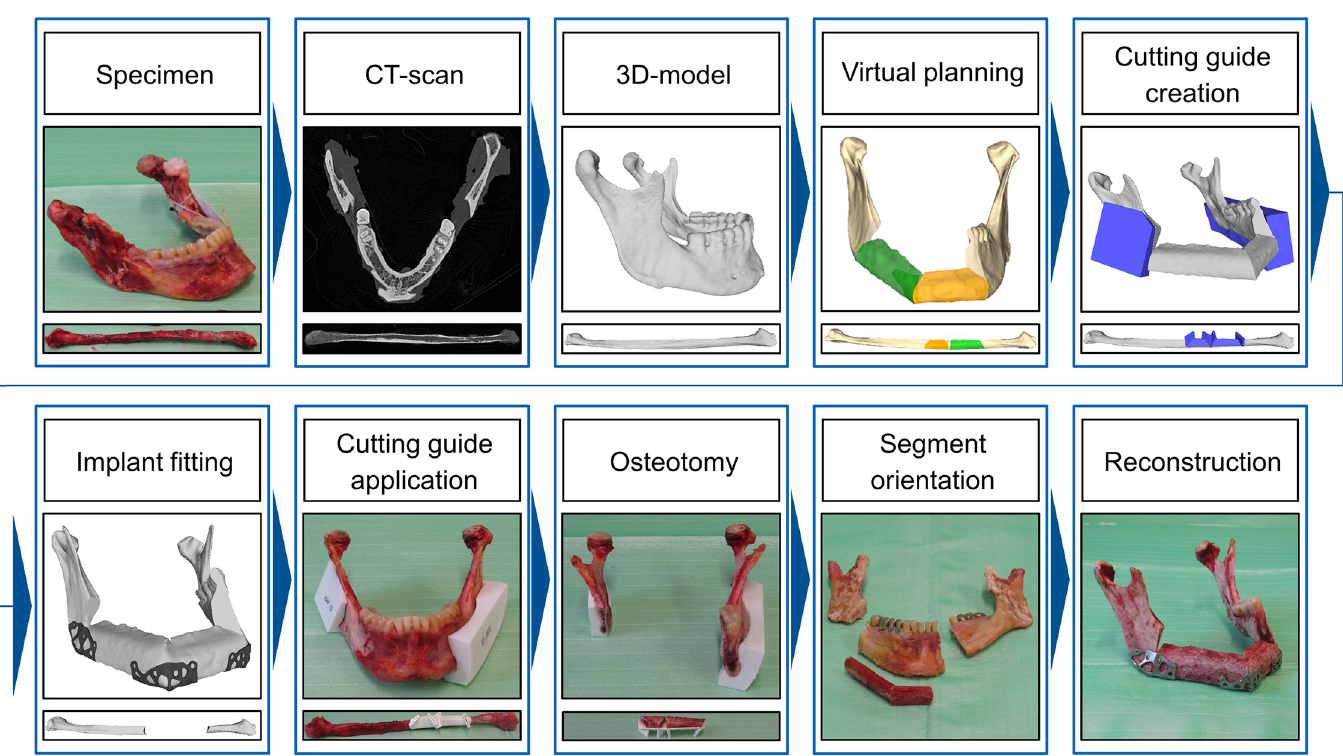
Fig 3. Process from bone to reconstruction. Stepwise process of creating the reconstruction specimen with topology optimized patient specific implants from the intact bone to the reconstructed mandible for testing. An experienced surgeon performed virtual planning and reconstruction. For reconstruction with miniplates the steps are similar but without the implant